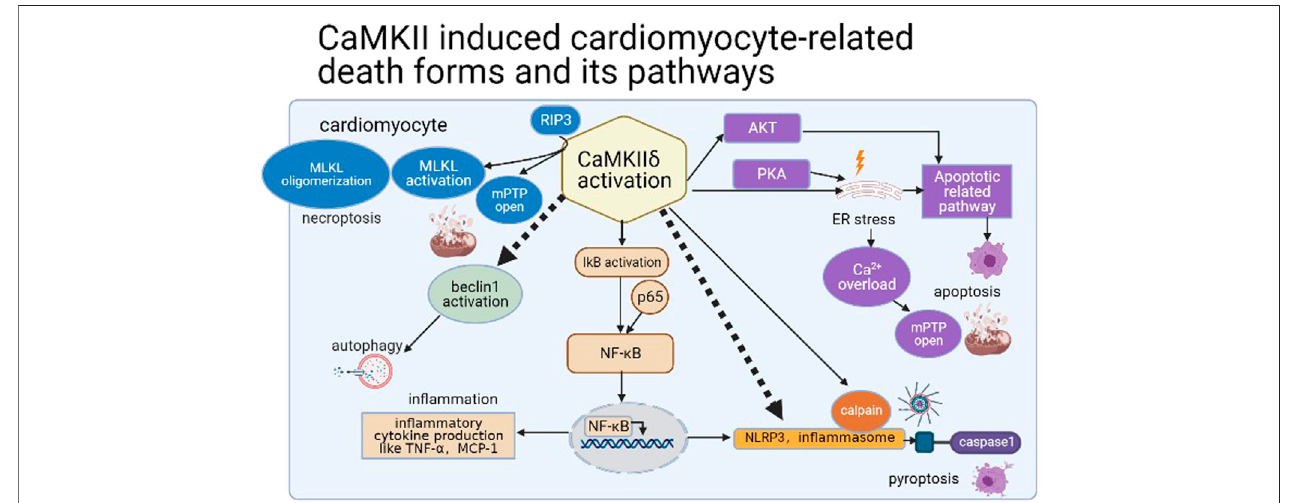
FIGURE 4 | CaMKII induced cardiomyocyte-related death forms and its